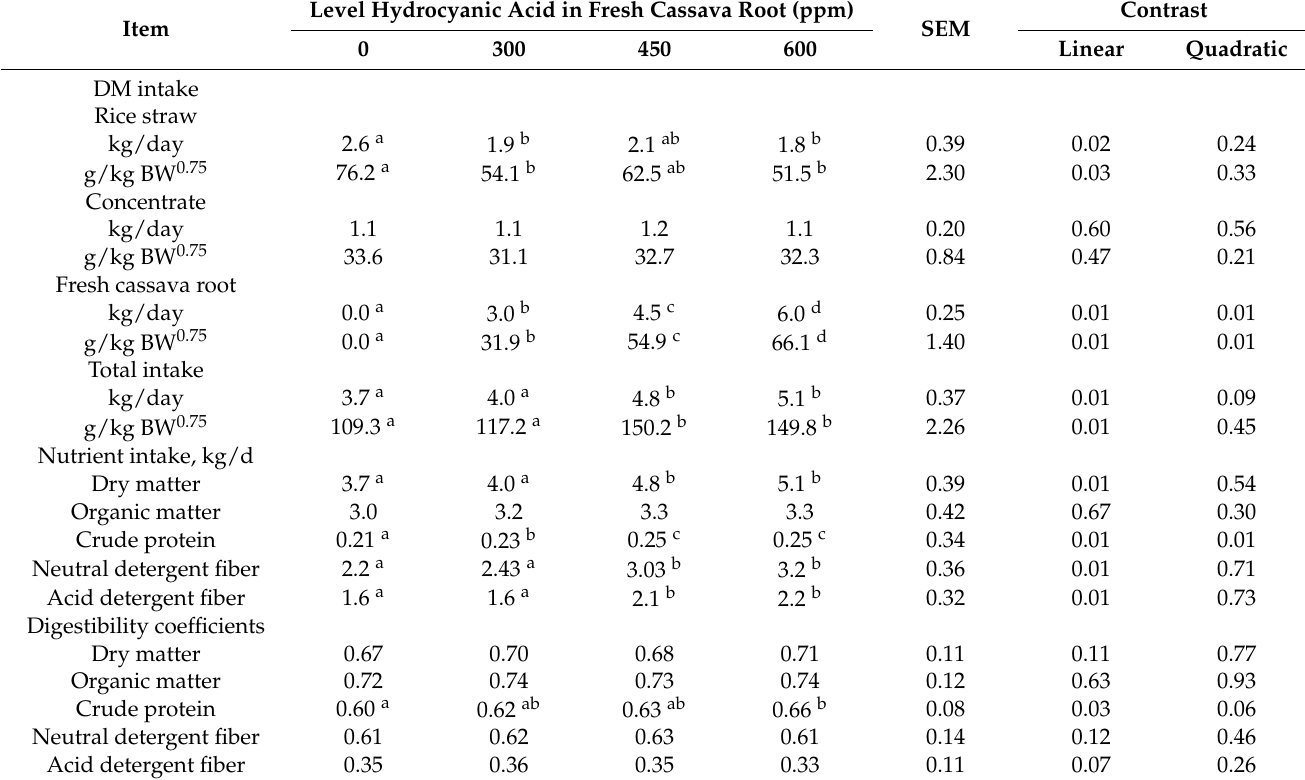
Table 2. Influence of different levels of fresh cassava root on feed intake, nutrient intake, and apparent digestibility in Thai native beef